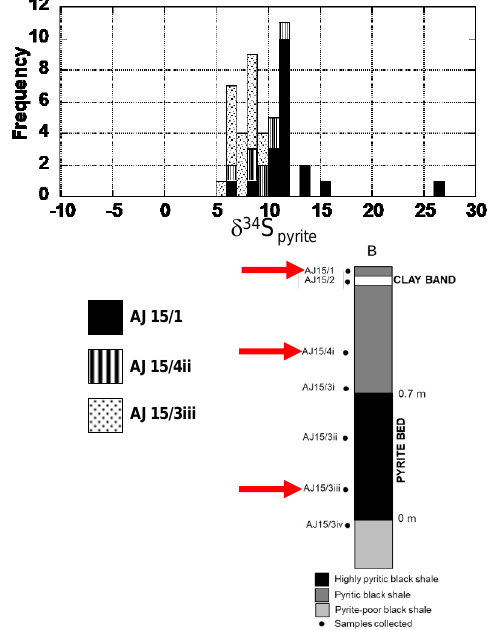
Figure 14. SHRIMP-SI Pyrite Sulfur isotope composition in the Bijaigarh Shale Unit.